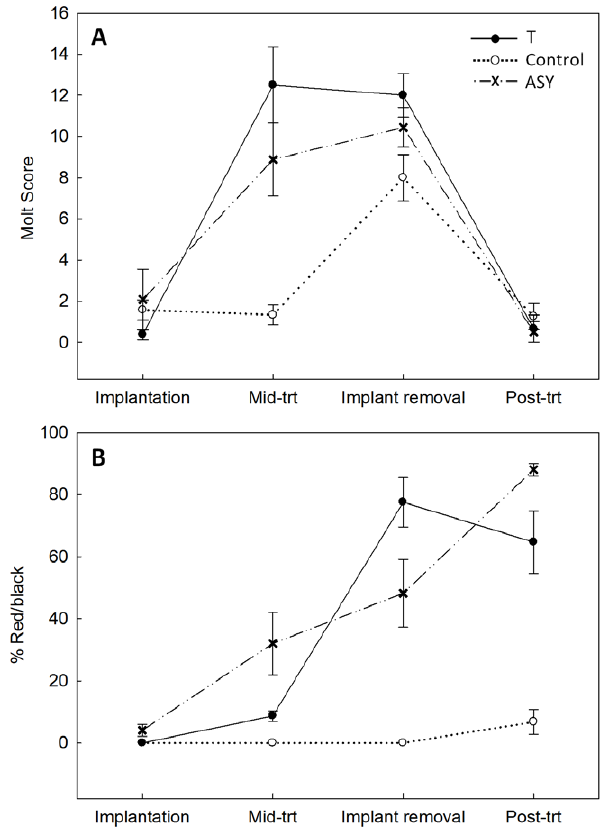
Figure 2. Treatment effects on molt score (A) and extent of nuptial plumage coloration (% red/black; B). Changes in mean response 6 SE for second-year testosterone (T) and control implanted males, and unmanipulated after-second year (ASY) males at implanta- tion, the mid-treatment recapture, implant removal, and the post- treatment recapture.